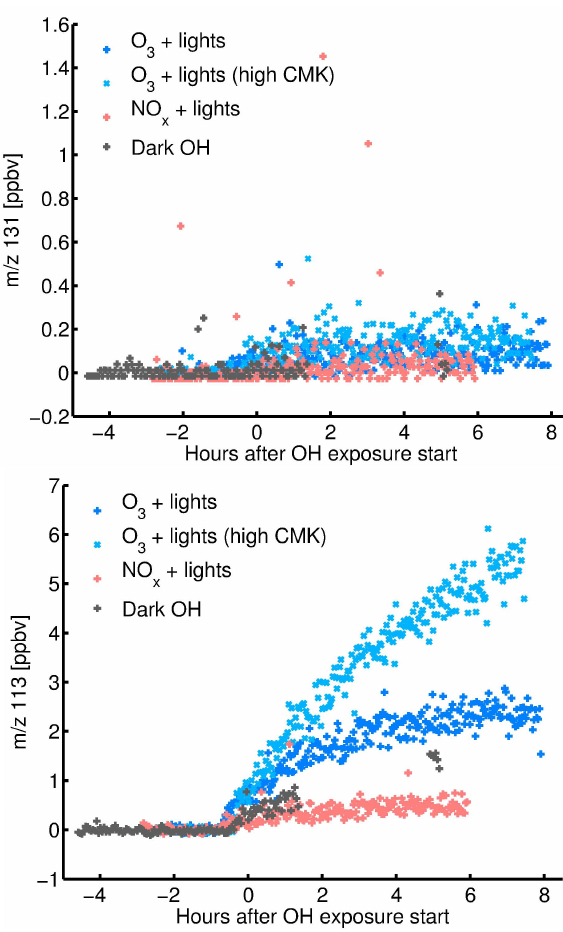
Fig. 3. Signals of m/z 131 (top) and 113 (bottom) from the proton- transfer-reaction mass spectrometer (PTR-MS). The hydroperoxide C 6 H 10 O 3 is mainly detected at m/z 113 since it looses a water molecule during protonation in the ionisation region of the PTR- MS. However, at this m/z there is an interference with the 2- acetylcyclobutanone (C 6 H 8 O 2 ), which is still measured in the ex- periment with NO x , while the hydroperoxide formation channel is suppressed.